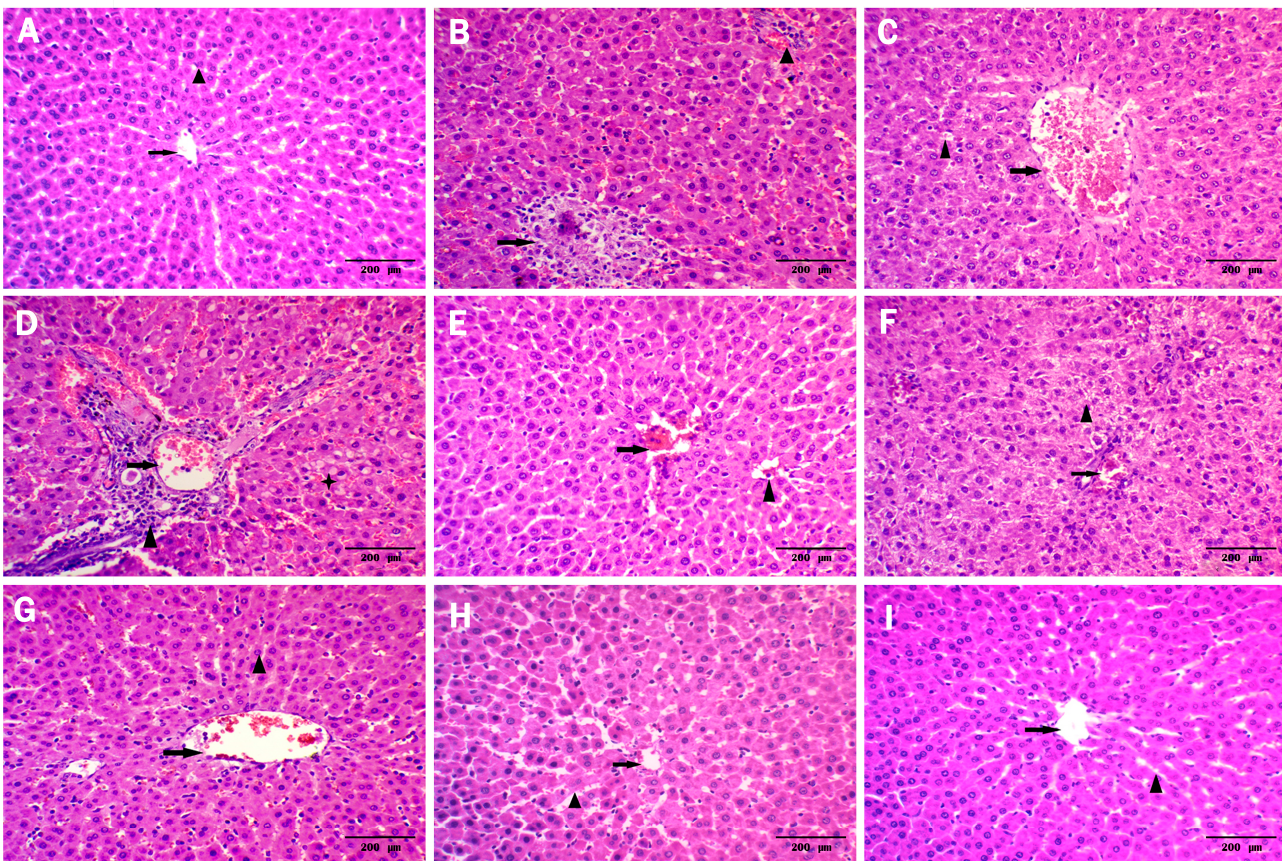
Figure 6. Effect of pretreatment with BBE , AgNPs, 200 or 50 BBE ‐ AgNPs and silymarin on histologic changes induced by hepatic I/R injury in rats. Photomicrographs represent ( A ) Sham, ( B – D ) IRI, ( E ) BBE , ( F ) AgNPs, ( G ) 200 BEE ‐ AgNPs, ( H ) 50 BBE ‐ AgNPs and ( I ) Silymarin.